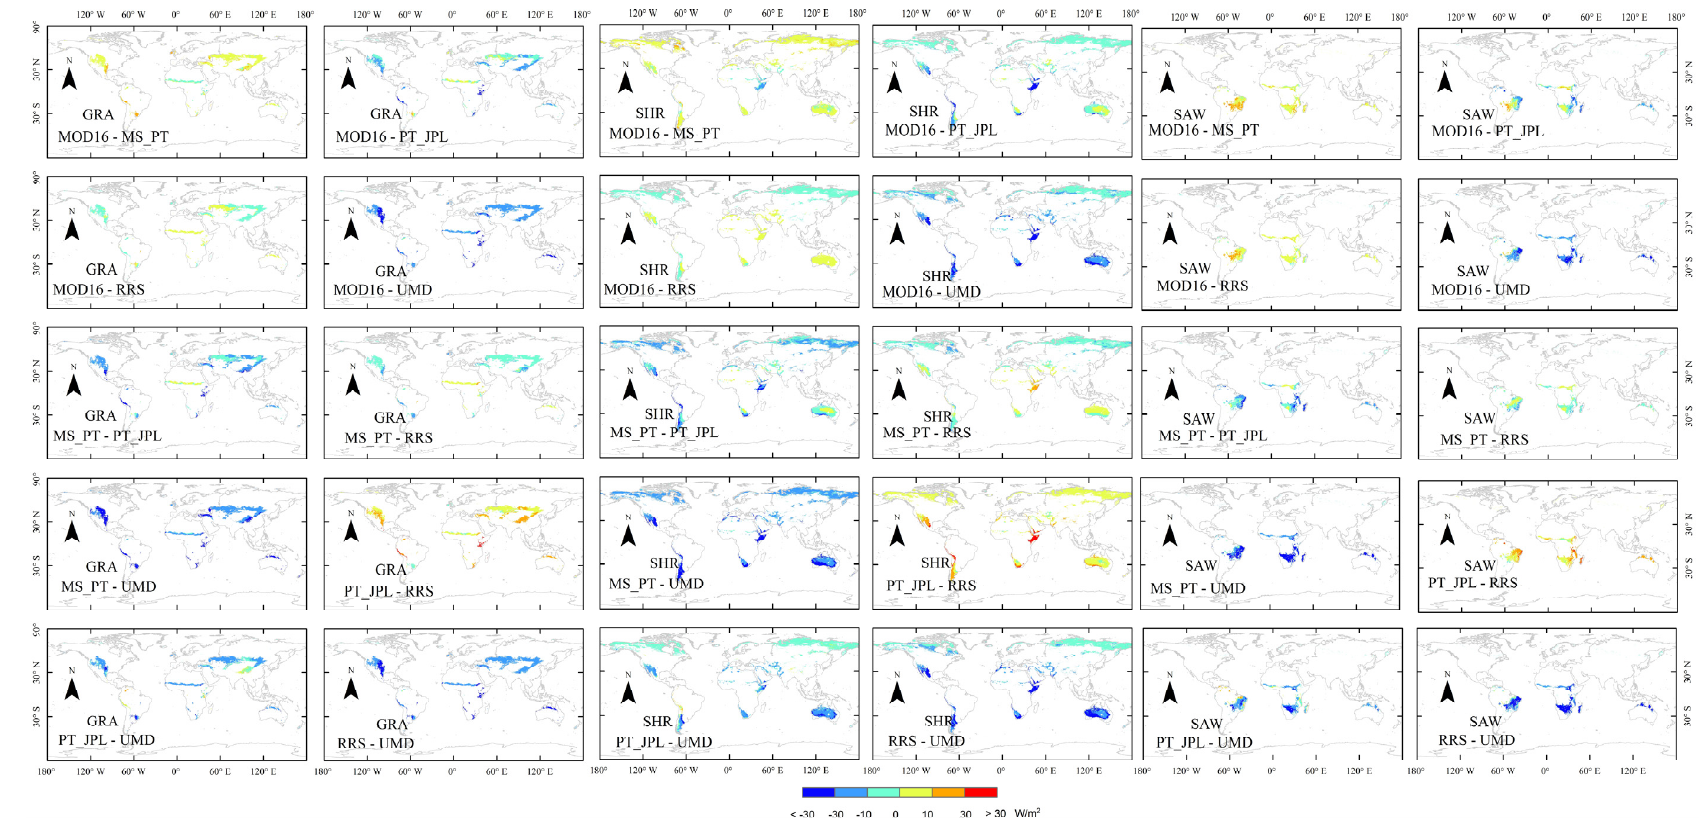
Figure 9. Estimated annual global terrestrial LE biases for three biomes (grassland, savanna, and shrubland) averaged for 2003–2006 at spatial resolution of 0.05° from the algorithms driven by GMAO-GERRA meteorology. Bias was computed as the difference of the models.